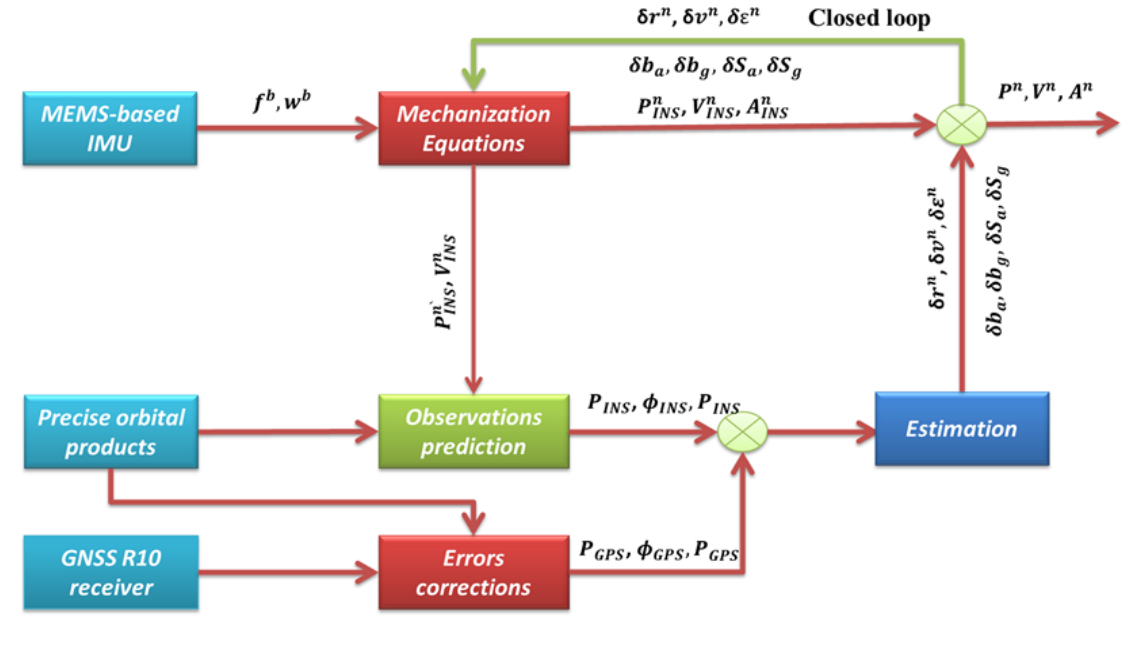
Figure 1. Flow chart of the proposed tightly coupled GPS PPP/MEMS integrated